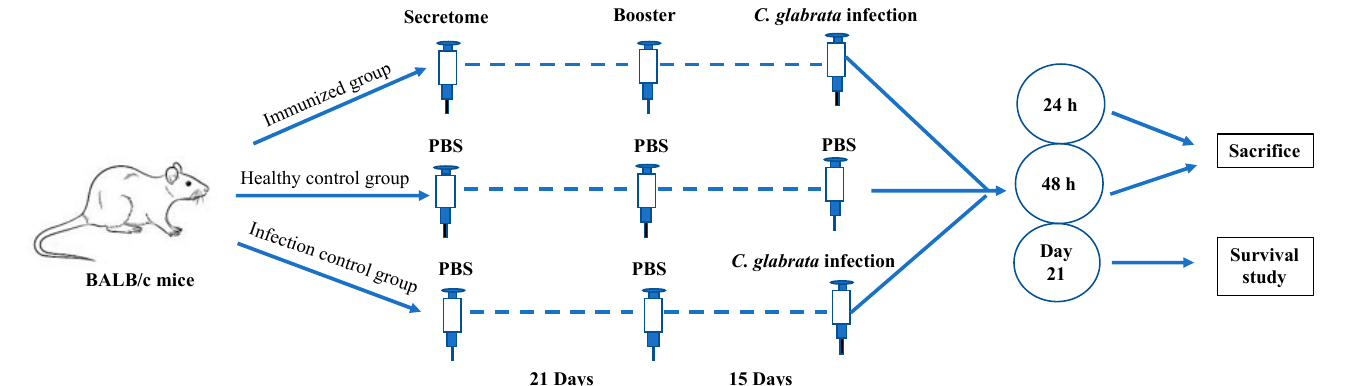
Figure 1. Candida glabrata secretome-immunized mice are protected from C. glabrata infection. BALB/c mice were vaccinated twice with either secretome or PBS alone. After 15 days of the booster, the mice were infected with a lethal dose of C. glabrata through the tail vein. Each group consisted of 10 mice; post-infection, animals showing signs of distress were sacrificed after 24 h and 48 h, whereas the rest were observed for the survival study until 21 days.